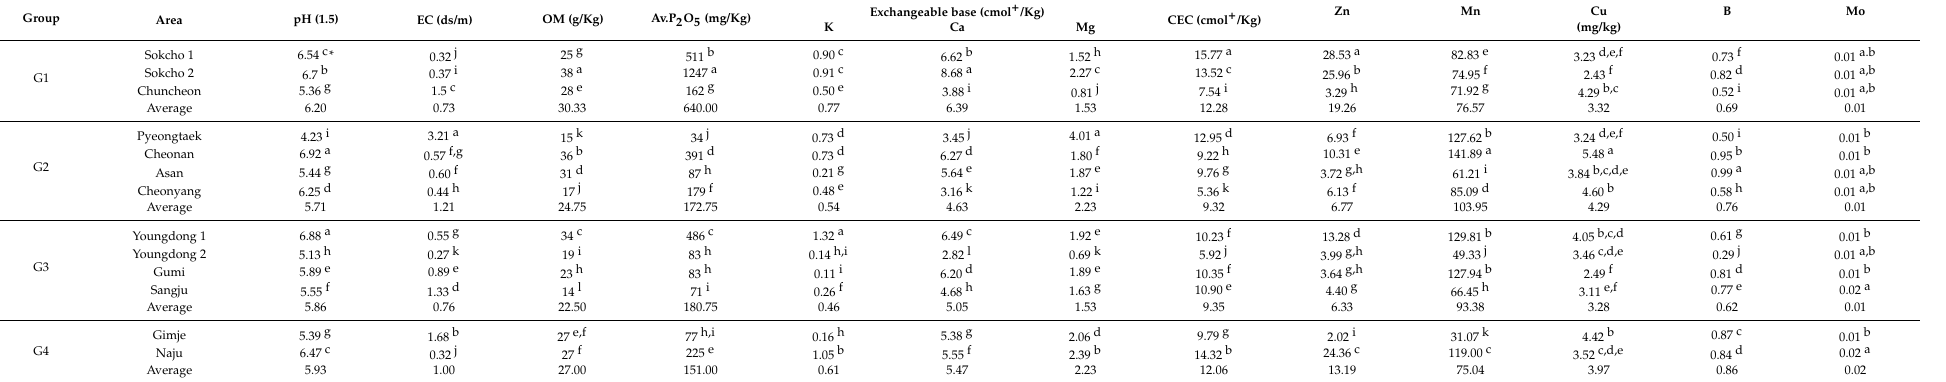
Table 9. Chemical components in soils at heading stage grown dehulled barley in different group areas in 2020.